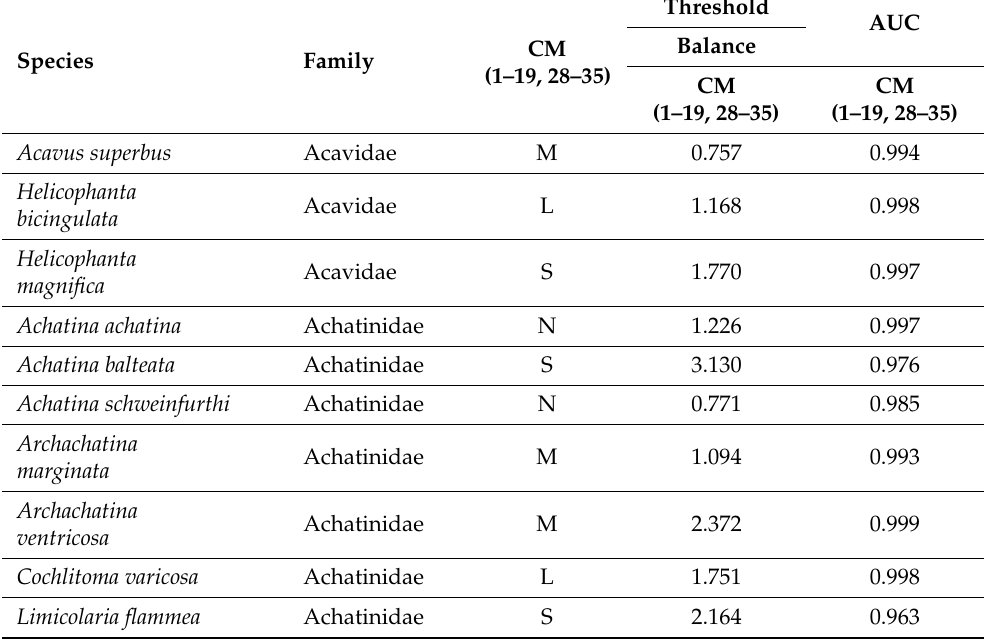
Table 3. The risk results for 29 species evaluated using MaxEnt. The climate matching (CM) for these bioclimatic layers (Bio1–Bio19, Bio28–Bio35) (Sup. 1) is based on the size of the predicted occurrence of the species: S—small area is defined by prediction of potential occurrence in Macaronesia in the southern part of the evaluated territory of the EU only; M—medium-sized area covering less than 5% of the territory; L—large area covering more than 5% of the territory; N—no risk. Species threshold values (the lowest probability value that is the minimum value for suitable habitat) were calculated during the modelling of predicted potential occurrence maps for each evaluated species. The models had a training AUC value over 0.95, suggesting high prediction